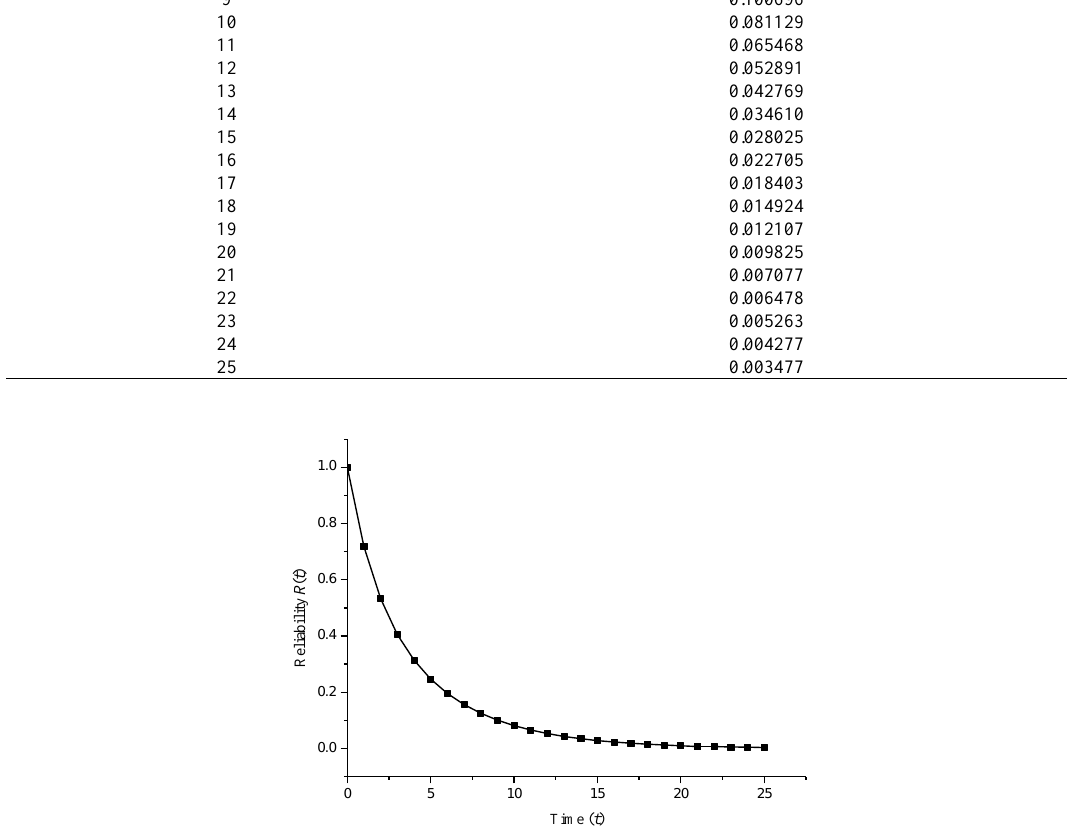
Figure 7. Reliability of the system with